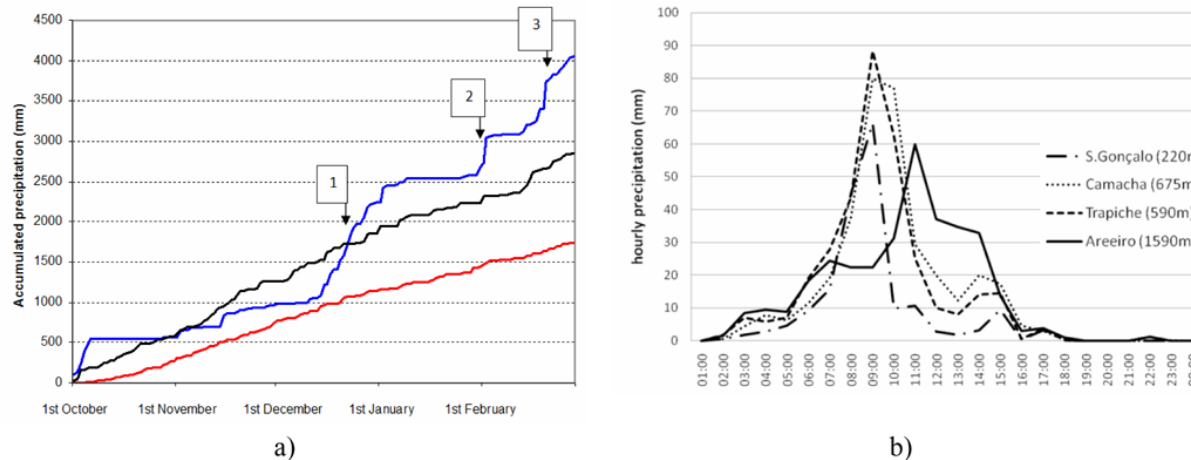
Fig. 3. (a) Accumulated daily precipitation (ADP) in Areeiro (station number 25 in Fig. 1) between 1 October 2009 and 28 February 2010 (blue line) and comparison with the long-term median (red line) and 95th percentile (dark line) of the ADP for the same time span, estimated over the 1936/37–2008/09 period. Indicated is the occurrence of three events (1) 22 December 2009 flash flood (2) 2 February 2010 heavy rainfall event (3) 20 February 2010 flash flood. Note: the represented precipitation data were recorded in different meteorological stations, however, just separated by a few metres and located approximately at the same height (20m of difference). (b) Hourly evolution of the 20 February 2010 rainstorm in Madeira, in four selected udographic stations from the Funchal city surroundings. Indicated hours in the abcissae axis are the ending time of the corresponding precipitation amount. The altitude (metres) of the four rain-gauge stations is inserted in the